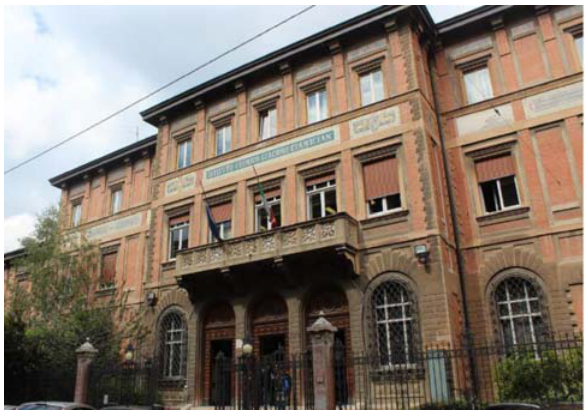
Figure 1. Main façade of the G. Ciamician Institute on Selmi Street, characterized by numerous decorations made with